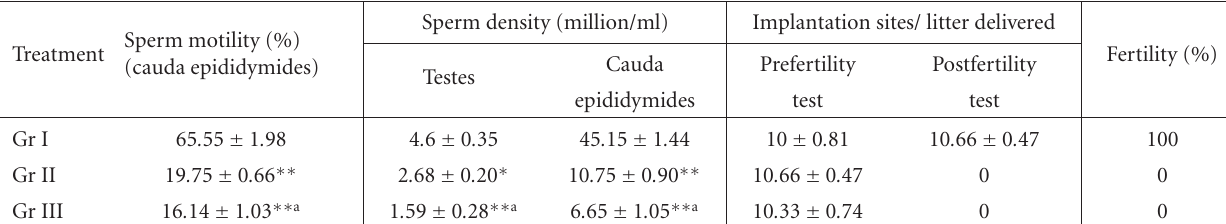
Table 3: Sperm dynamics and fertility after the treatment of compounds 1 and 2 (values are mean ± SEM ( n = 6)). Sperm motility (%) Treatment (cauda epididymides)